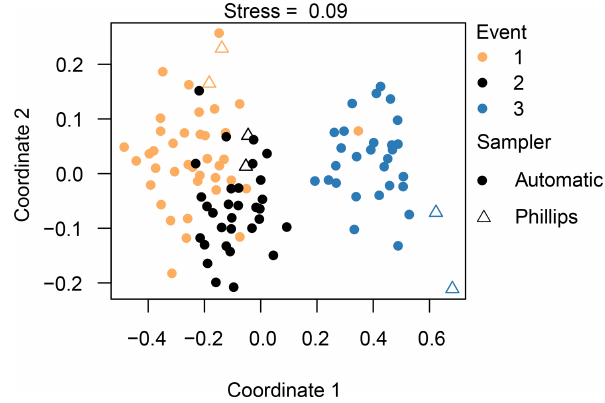
Figure 6. Non-metric dimensional scaling (NMDS) analysis of the diatom communities, indicating the different events and sampling methods. Species data underwent a Hellinger transformation and the Euclidean distance was used. A stress value below 0.10 consti- tutes an ideal representation of the data according to Clarke